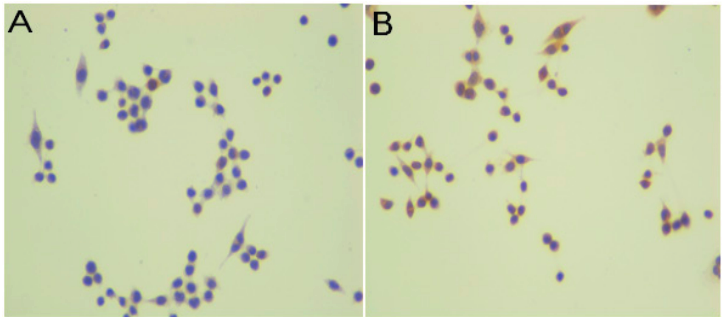
Figure 2. Immunostaining results in the SW620 human colon adenocarcinoma cell line. DAB method, hematoxylin-counterstained; magnification: 100×. IGF-2 staining. Cells were exposed to 3 mM 5-ALA for 4 h without light ( A ) and then treated with light ( B ); IGF-2 receptor: cells were exposed to 3 mM 5-ALA for 4 h without a light ( C ) and with light ( D ); IGF-2BP-1 staining: cells were exposed to 3 mM 5-ALA for 4 h without light ( E ) and with light ( F ); negative control ( G ).